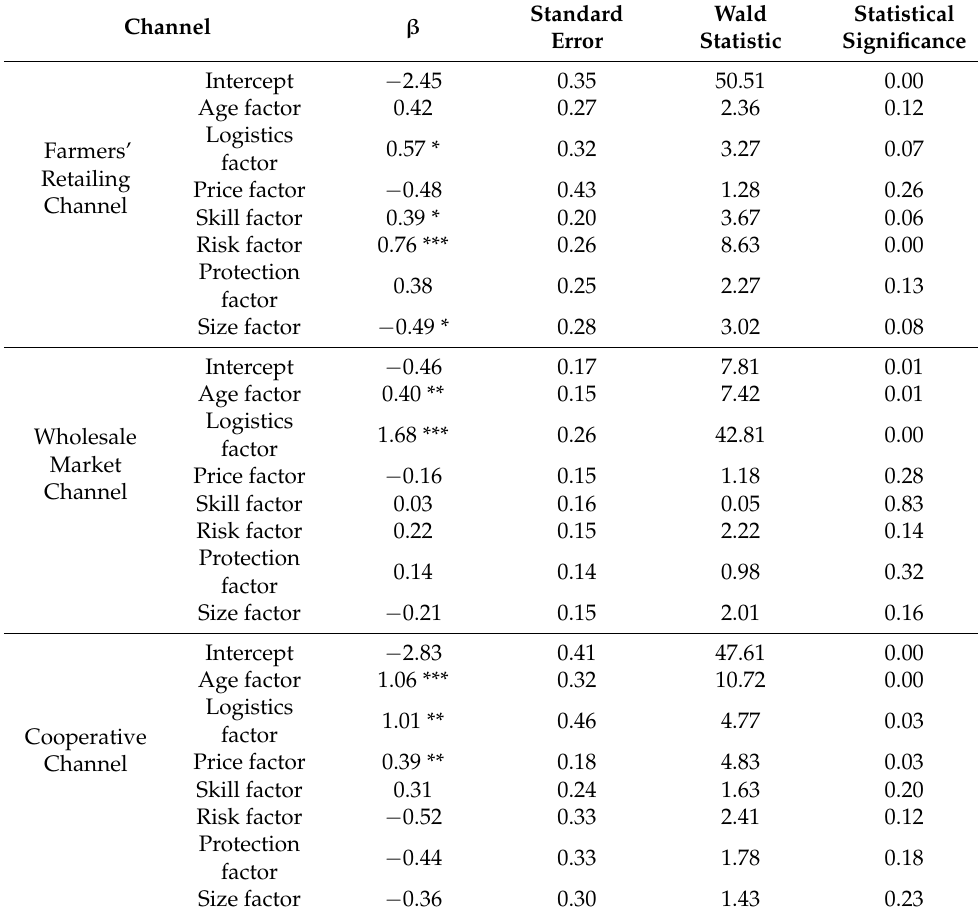
Table 6. Estimation results of multivariate selection